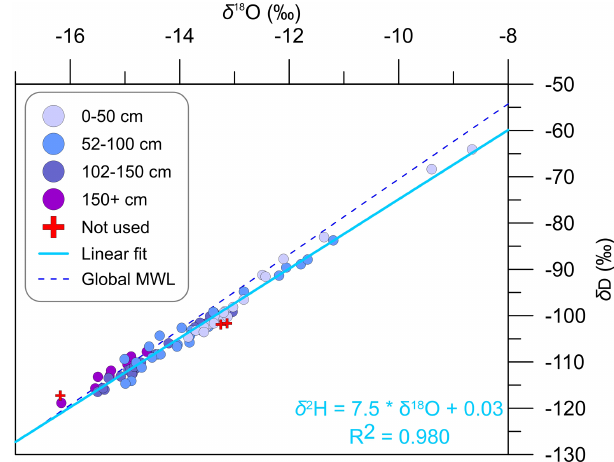
Figure 8. Plot of δ 18 O vs. δ D for ice samples from the Skating Rink exposure (Fig. 1c). Samples are color-coded to highlight their depth below the top of the exposure. Three samples identified as outliers and discarded from the dataset are marked with red crosses. The solid light-blue line represents a linear regression through the remaining 81 samples, and the equation for this line is presented in the lower right corner. The dashed blue line is the global meteoric waterline (Craig,